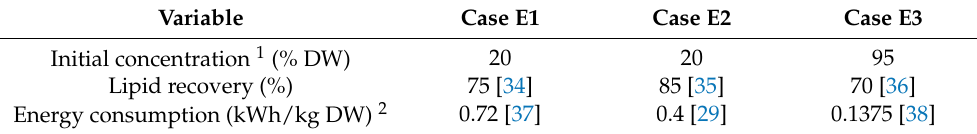
Table 3. Operating conditions for the technologies involved in the pretreatment stage (cell